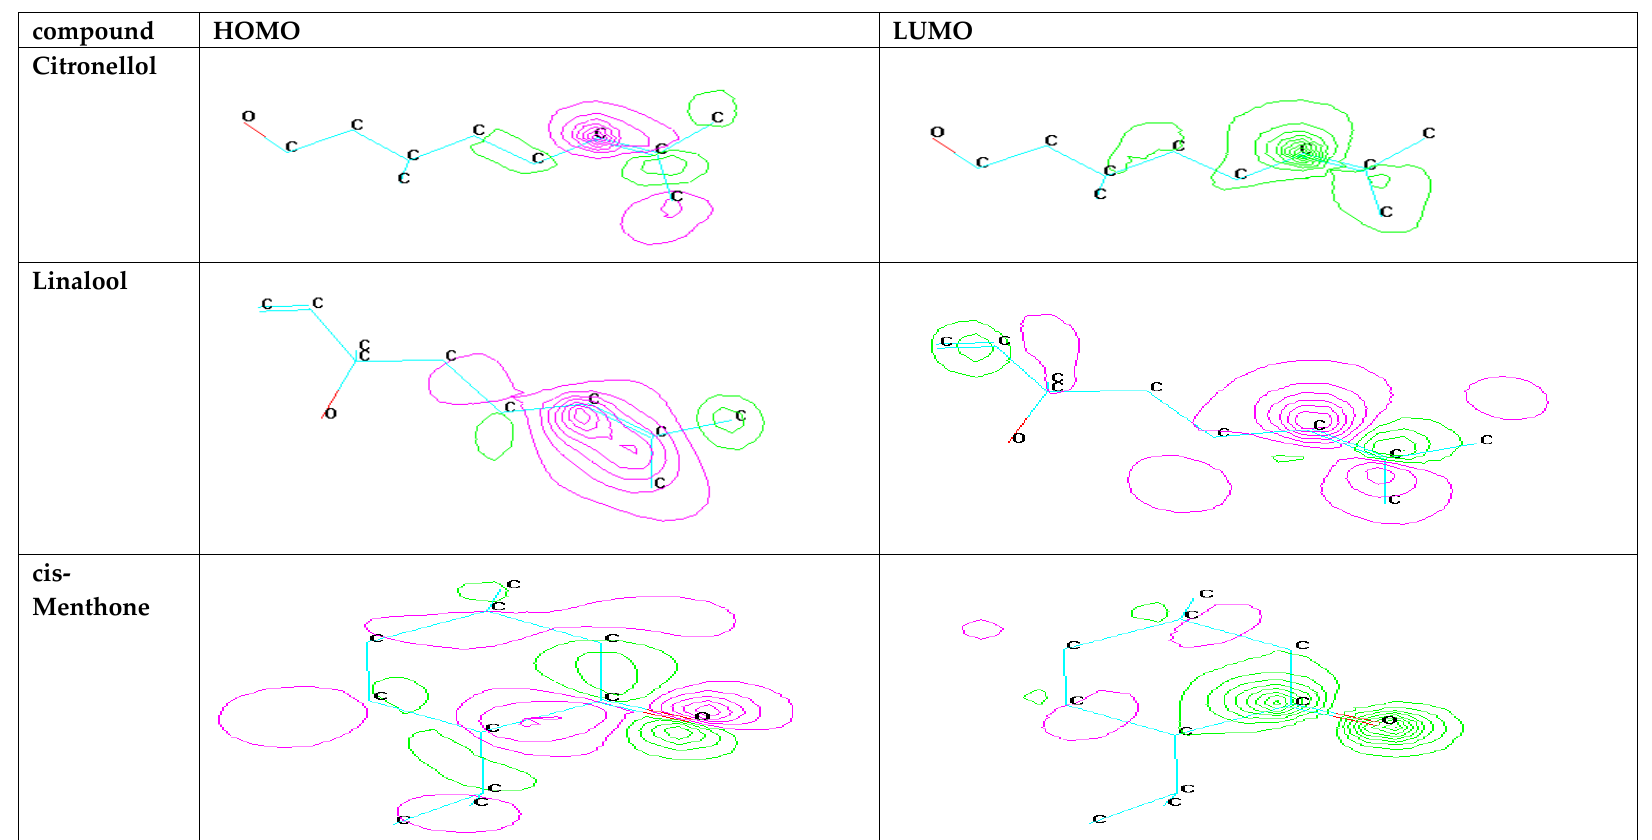
Figure 4. 2D contours HOMO and LUMO of the studied compounds using MNDO method.